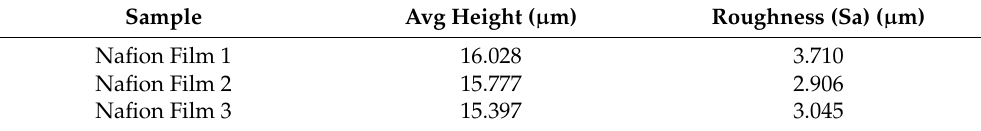
Table 2. LSCM film thickness and roughness measurements of screen-printed Nafion membranes.